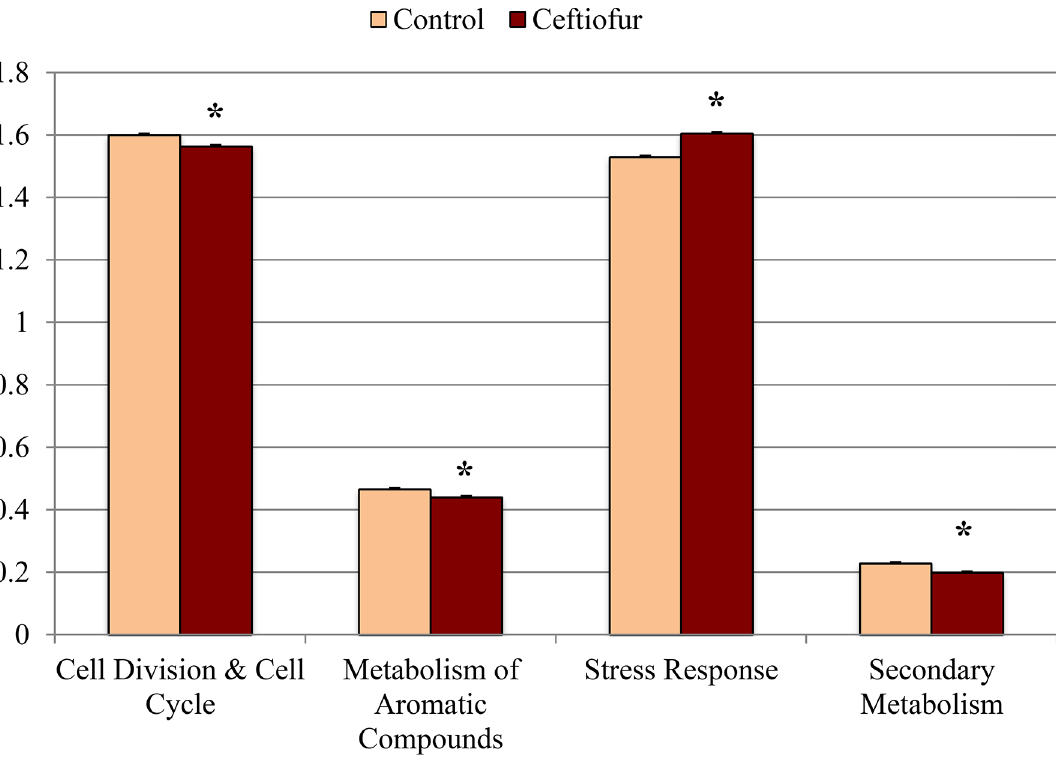
Fig 7. Abundance of “ cell division and cell cycle ” , “ metabolism of aromatic compounds ” , “ stress response ” , and “ secondary metabolism ” sequences in fecal samples collected from control (n = 3) and ceftiofur crystalline free acid treated (n = 3) cows on day 3 post-treatment. Day 0 (pre-treatment) samples were used as a covariate. Values are expressed as a percentage of the total sample sequences assigned function. The symbol * indicates significant differences ( P (cid:1) 0.10).